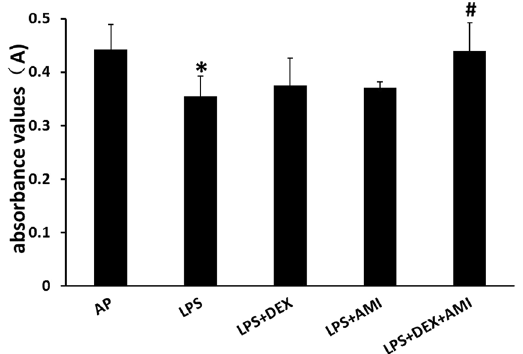
Figure 5. The combination treatment of aminophylline and dexamethasone mitigates ototoxic reductions of HDAC2 levels induced by LPS in the cochlea. Guinea pigs treated with LPS only had a significantly lower level of HDAC2 in cochlear tissues compared to the AP group ( * p < 0.5). The level of HDAC2 was significantly increased after treating with a combination of DEX and AMI compared to the untreated, LPS-exposed group ( # p < 0.05). However, no significant change in the level of HDAC2 was observed in the LPS + DEX or LPS + AMI groups compared to the LPS only group (all p > 0.05).